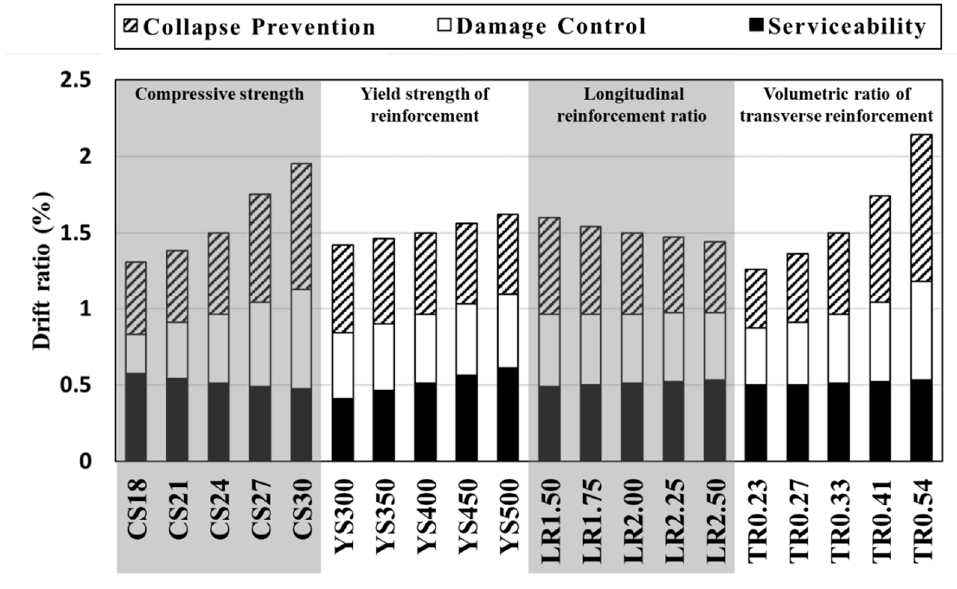
Figure 5. Interstory drift ratio corresponding to the limit states of each structure.